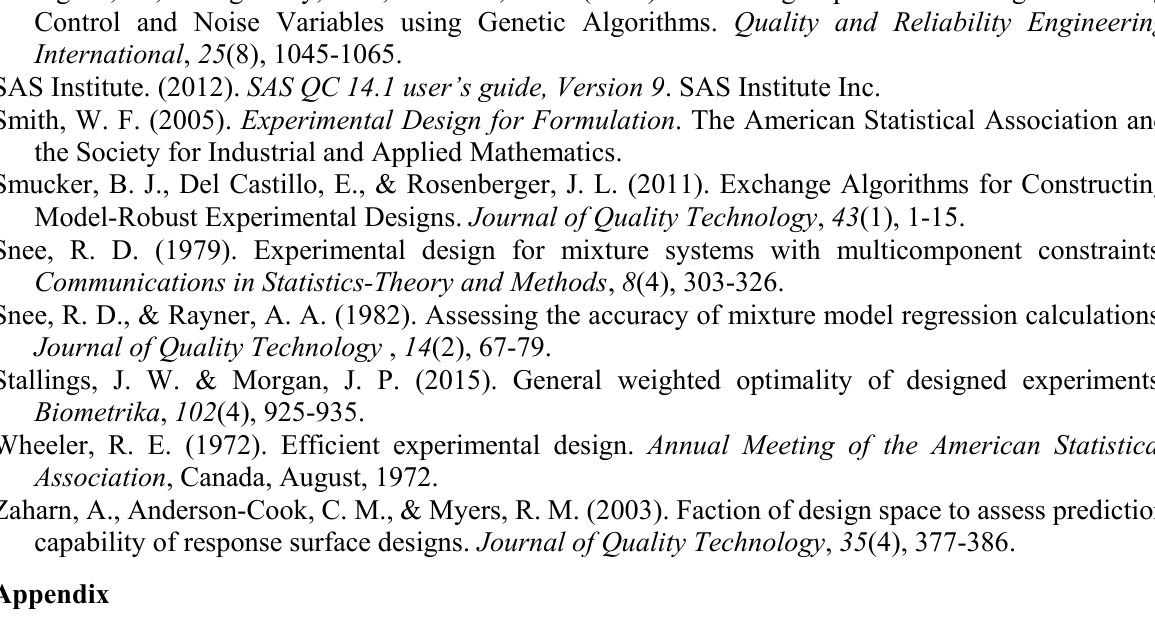
The WG-optimal exact designs produced by our genetic algorithm are shown in this appendix. The WG10 designs for the poultry